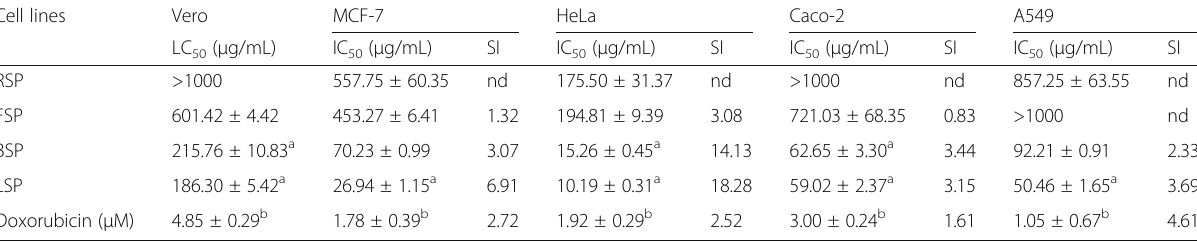
Table 3 Cytotoxic activity (LC 50 and IC 50 in μ g/mL) and the selectivity index (SI) of extracts from roots, fruits, bark and leaves of Sarcocephalus pobeguinii and reference drug (doxorubicin) against cancer cell lines Cell lines